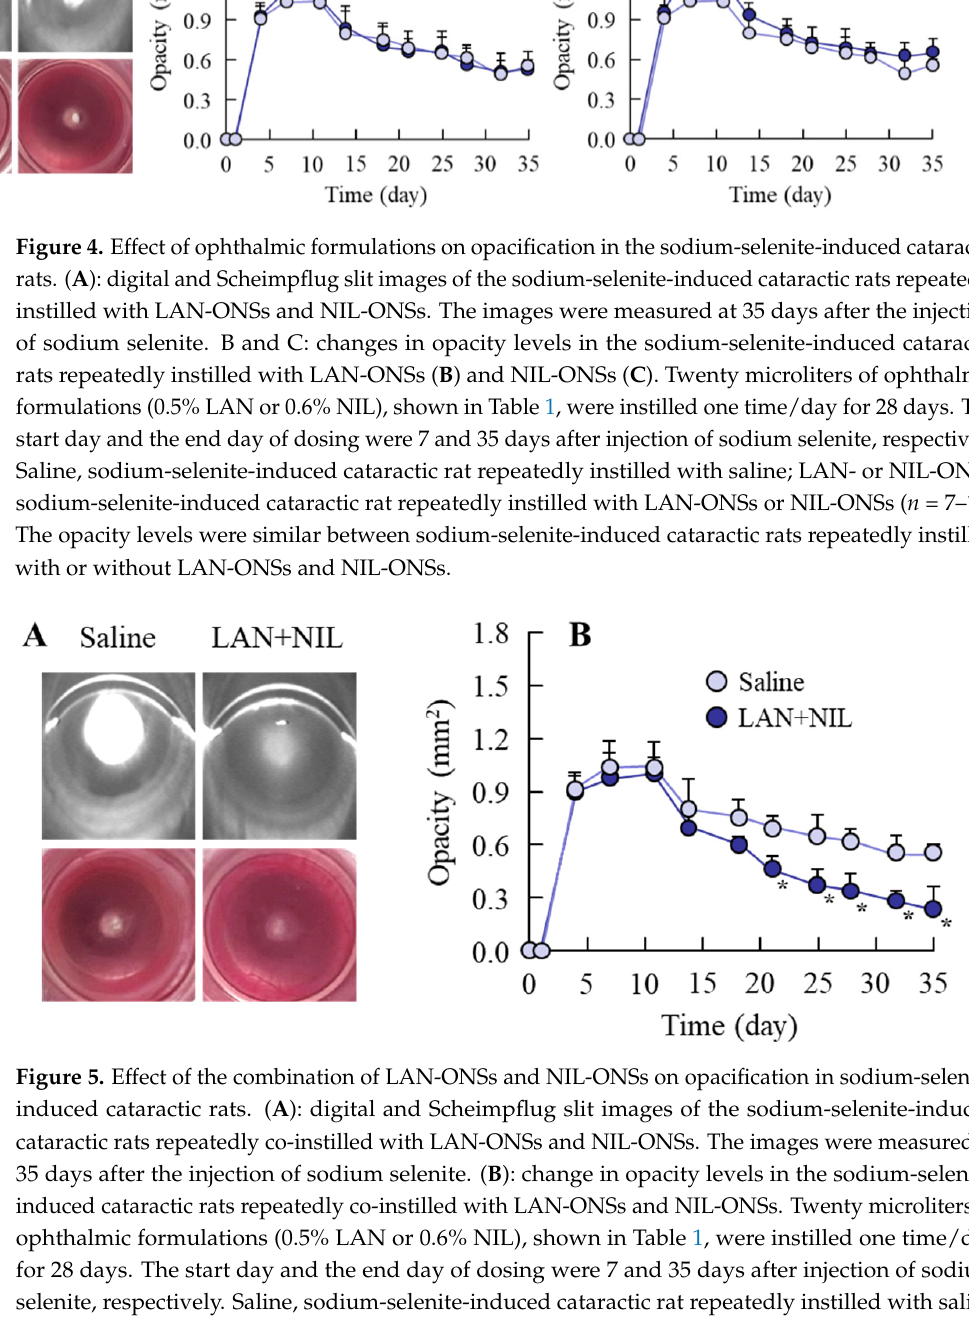
Figure 3. Changes in sodium-selenite-induced opacification in rat lenses. ( A ): digital and Scheimpflug slit images in cataractic rats 0, 7, and 35 days after the injection of sodium selenite. ( B ): changes in opacity levels in the sodium-selenite-induced cataractic rats ( n = 12). The lens opacifica- tion was caused by the injection of sodium selenite, and the opacity level was observed at 3 d after the injection.